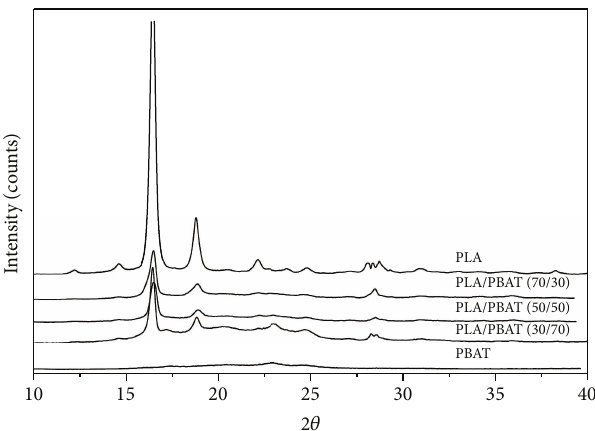
Figure 5: WAXD patterns of PLA/PBAT blends annealing at 100 ∘ C for